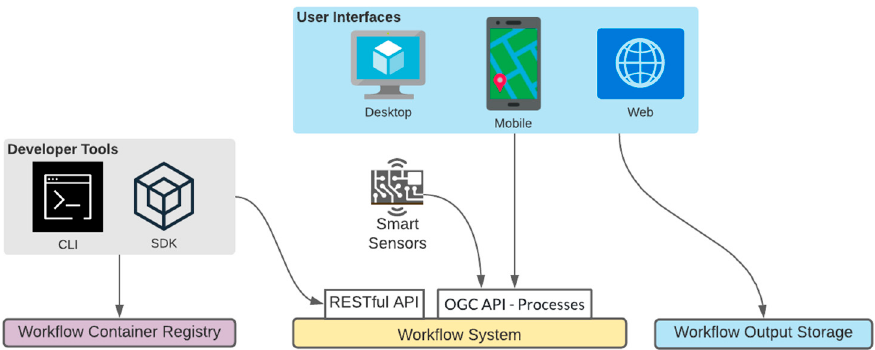
Figure 11. Client application types and their relations with the system